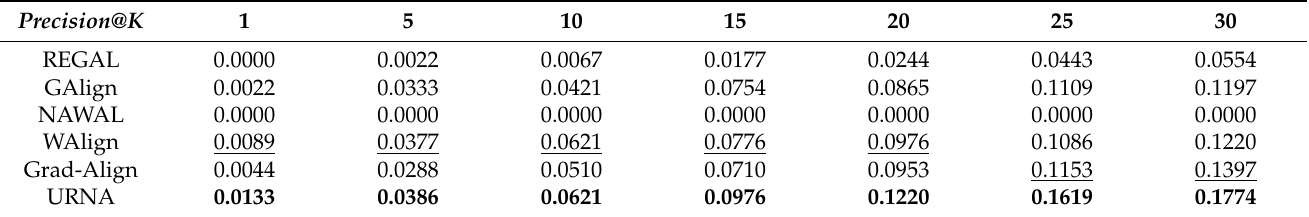
Table 6. Experimental results on flickr/lastfm given different Precision @ K settings. Here, the best and second best performers are highlighted by bold and underline, respectively.